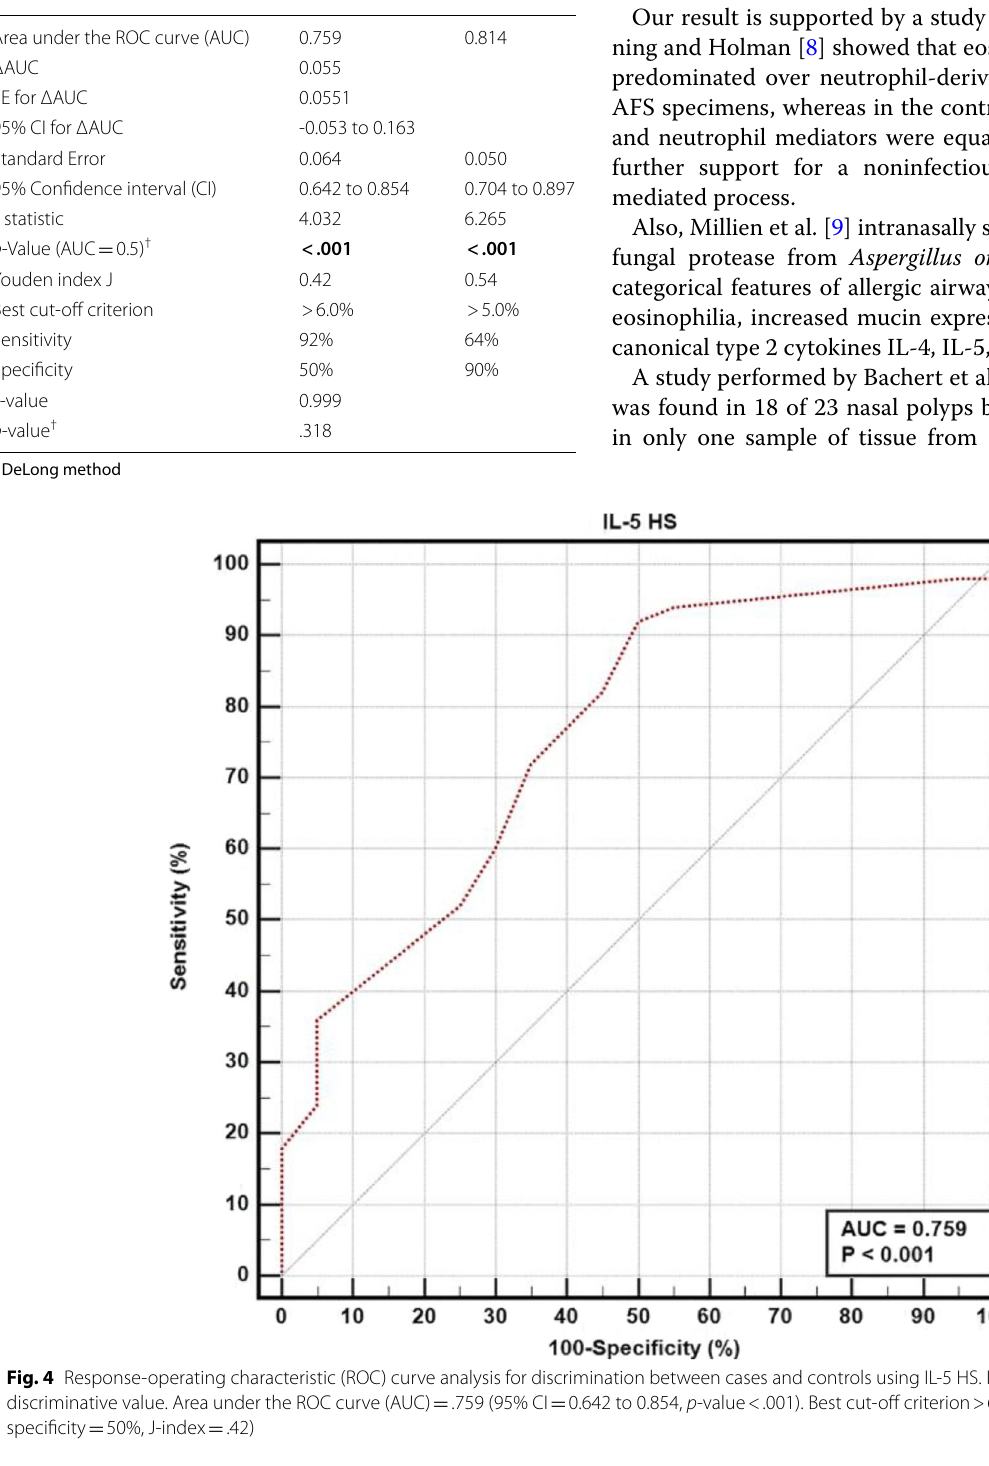
.759 (95% CI 0.642 to 0.854, p -value < .001). Best cut-off criterion > 6.0% (sensitivity = =